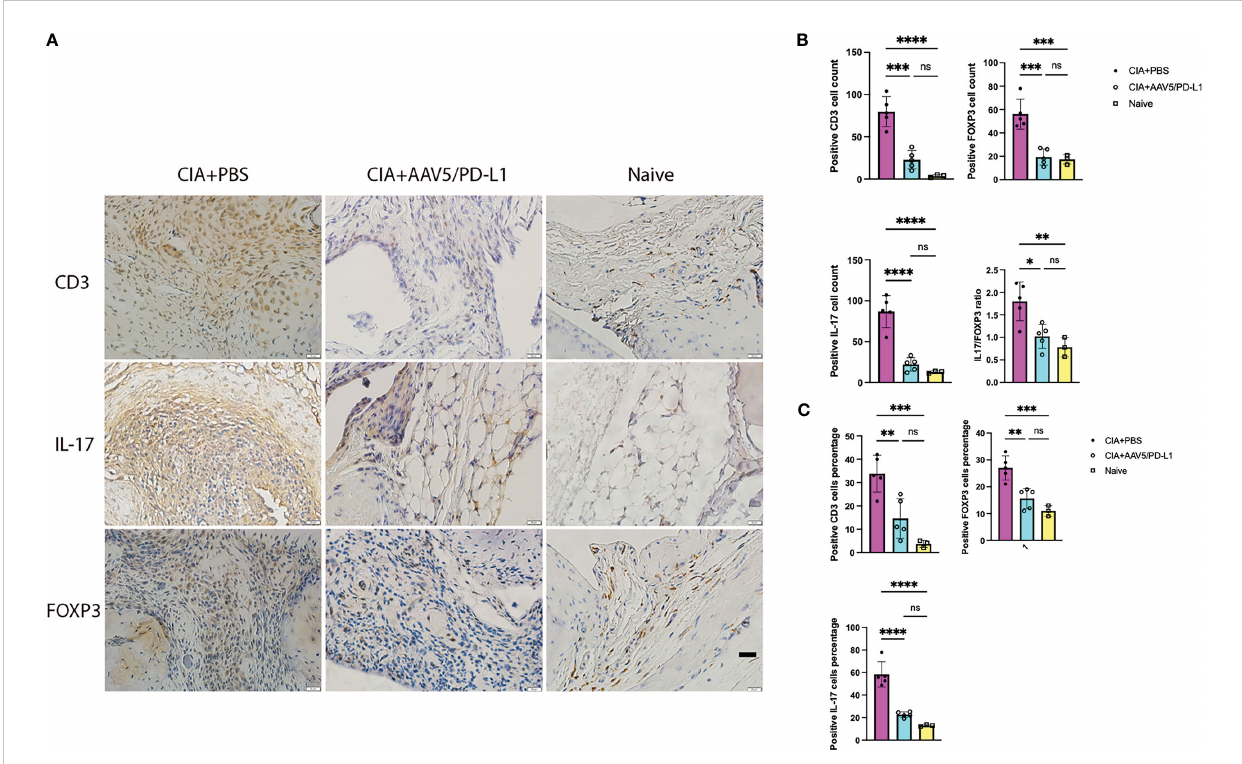
FIGURE 4 In fi ltration of T-cells in the synovium was reduced in PD-L1 treated joints with AAV vectors for prophylactic treatment. (A) , Immunohistochemistry staining for T cells. Representative images of in situ immunohistochemical visualization of T cells stained with antibodies against CD3, IL-17, FOXP3 (bar=20 m m) is shown in CIA mouse knees treated with PBS, AAV5/PDL1, or naïve mice. B-C, Total number (B) and cell percentage (C) for CD3, IL-17 and FOXP3. The cells were counted in 10 fi elds of view and averaged in each joint. Each dot represents one mouse joint. Five knee joints were analyzed in each group. Mean values are shown with standard derivation (n=5). Data was analyzed using one-way ANOVA followed by Bonferroni multiple comparison test for group comparisons. *, p < 0.05, **, p < 0.01, ***, p < 0.005, ****, p < 0.001. ns, not signi fi cant (p ≥